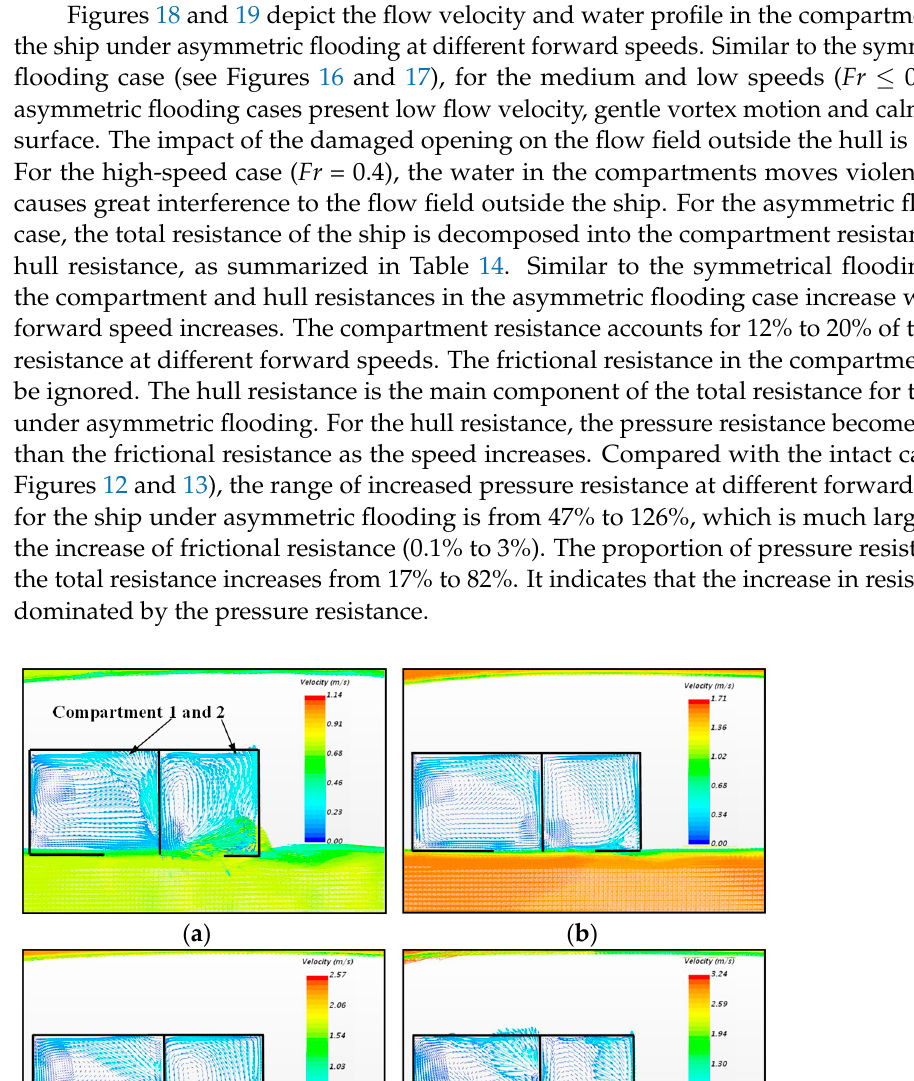
( d ) Figure 19. Comparison of water surface in compartments for the ship under asymmetric flooding at different speeds: ( a ) Fr =0.1 ( b ) Fr =0.2 ( c ) Fr =0.3 ( d ) Fr =0.4. Table 14. Resistances of compartment and hull and proportions to the total resistance under the asymmetric flooding case (unit: N). Fr Compartment Hull Frictional Resistance (Proportion)